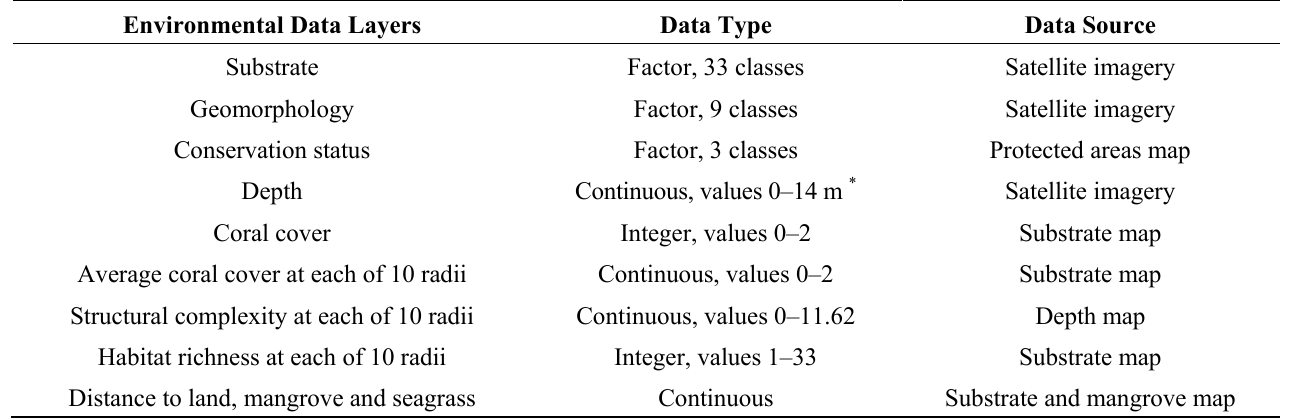
Table 3. Environmental data layers derived from satellite data and their data